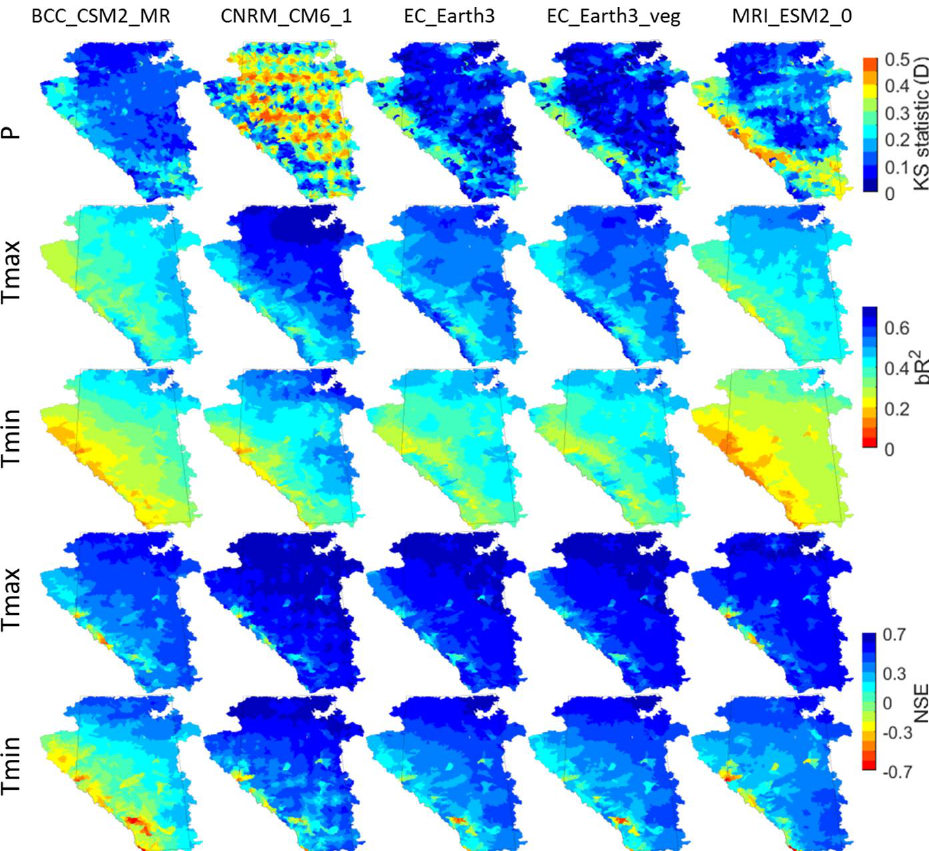
Figure 4. The spatial pattern of verification metrics between GCM simulation and observed data for the period of 1983–2014. Here, the KS test is used for P and the bR 2 and NSE are used for both Tmax and Tmin. Red and blue colour indicate poor and good performance of individual GCMs,